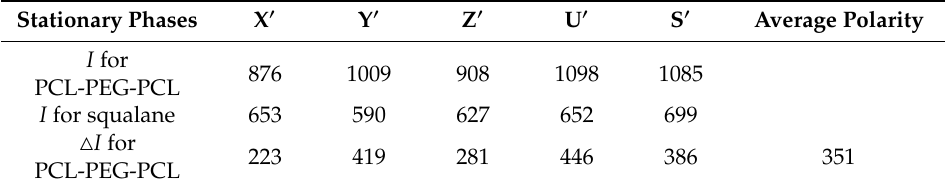
Table 1. McReynolds constants of the PCL-PEG-PCL column.